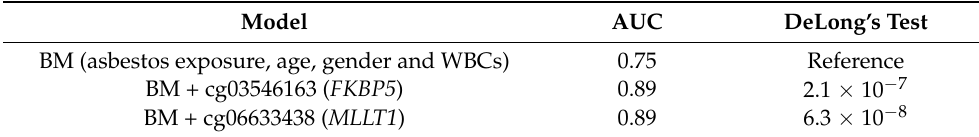
Table 2. Disease discrimination test considering (AUC) comparison between baseline model and models additionally including single-CpG.